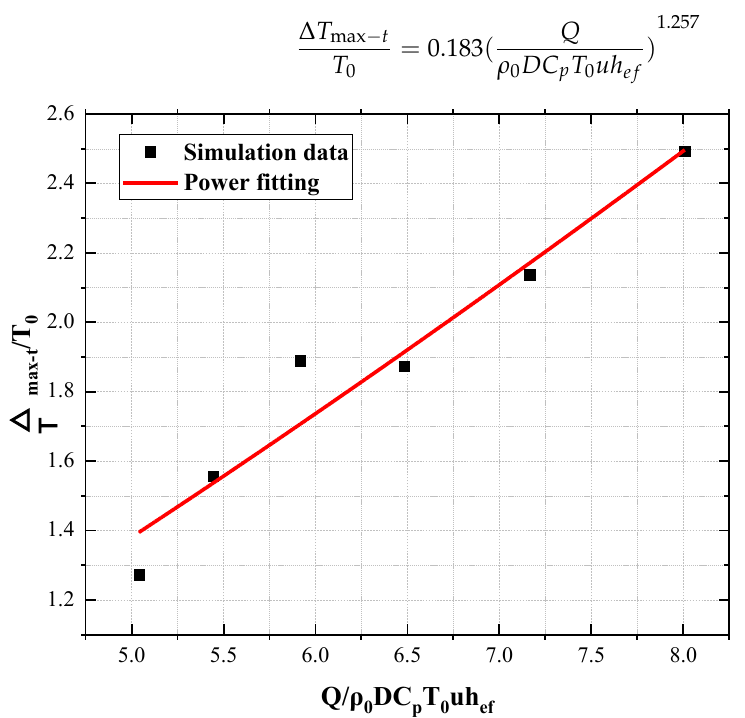
Figure 7. Dimensionless maximum excess temperature of the truss versus modified dimensionless heat release rate.